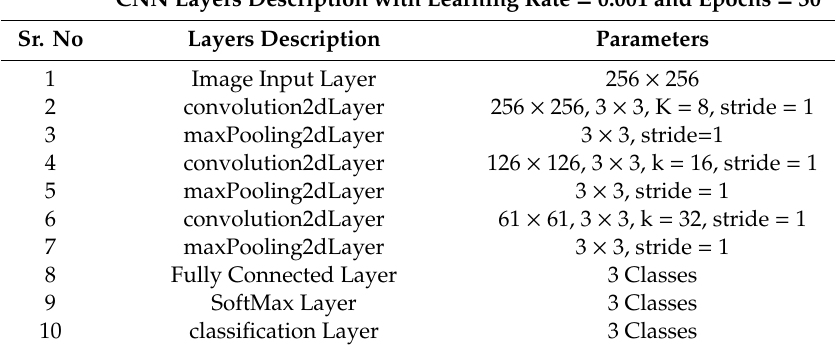
Table 2. Description of Layers of Classification-Net CNN (CN-CNN).